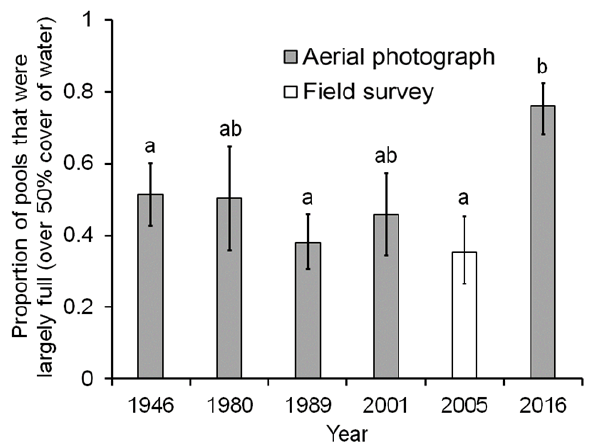
Figure 7. Changes in pool fullness over time. Estimated mean (and standard error) of proportions of pools per pool group that were largely full (over 50 % cover of water) in six survey years between 1946 and 2016. The Figure shows fitted year-wise means from the model reported in Table 3. The model includes recent rainfall as a covariate; year-wise mean estimates are for mean values of recent rainfall (~ 63 mm per month in the survey month and previous two months, averaged across Wick and Stornoway weather stations). Note that 2005 results were based on field survey, while results from other years were based on interpreting aerial photographs. Letters indicate year-wise means that were significantly different (Tukey-adjusted P - value < 0.05).